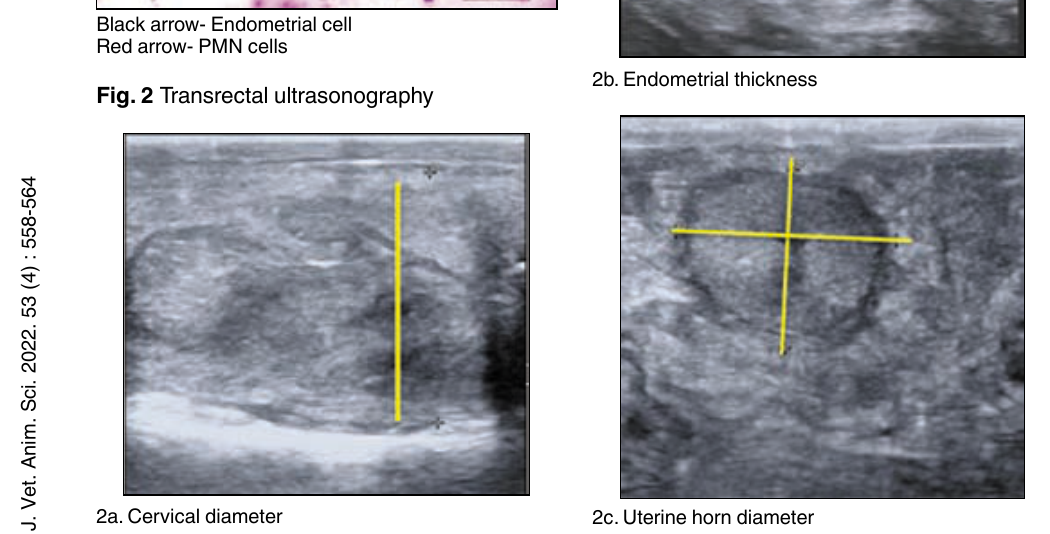
2c. Uterine horn